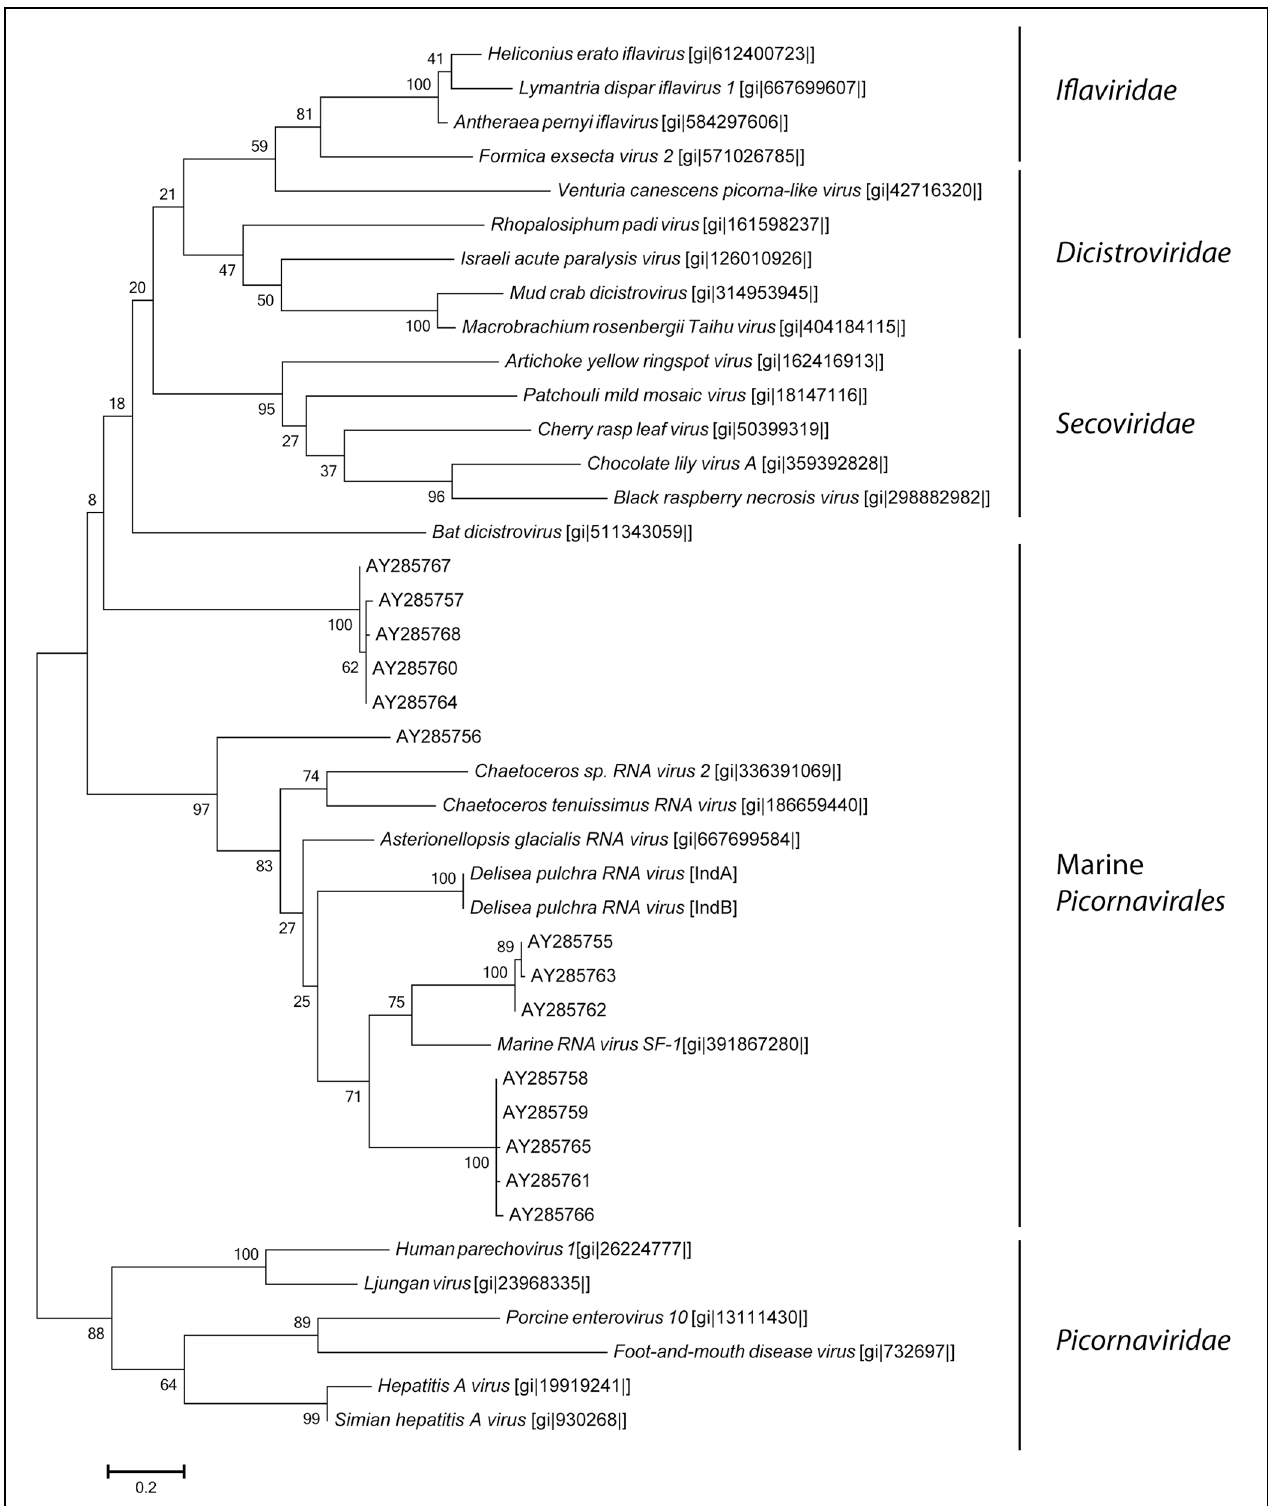
FIGURE 4 | Maximum-likelihood phylogenetic tree of D. pulchra associated Picornavirales based on the RdRp amino acid sequence compared to environmental sequences (AY285750-AY285768) of virioplankton communities of geographically diverse regions (Culley et al., 2003) and to the families Iflaviridae, Picornaviridae , Dicistroviridae, and Secoviridae . NCBI accession numbers are shown in brackets. The scale bar represents 20% of amino acid changes between close relatives.